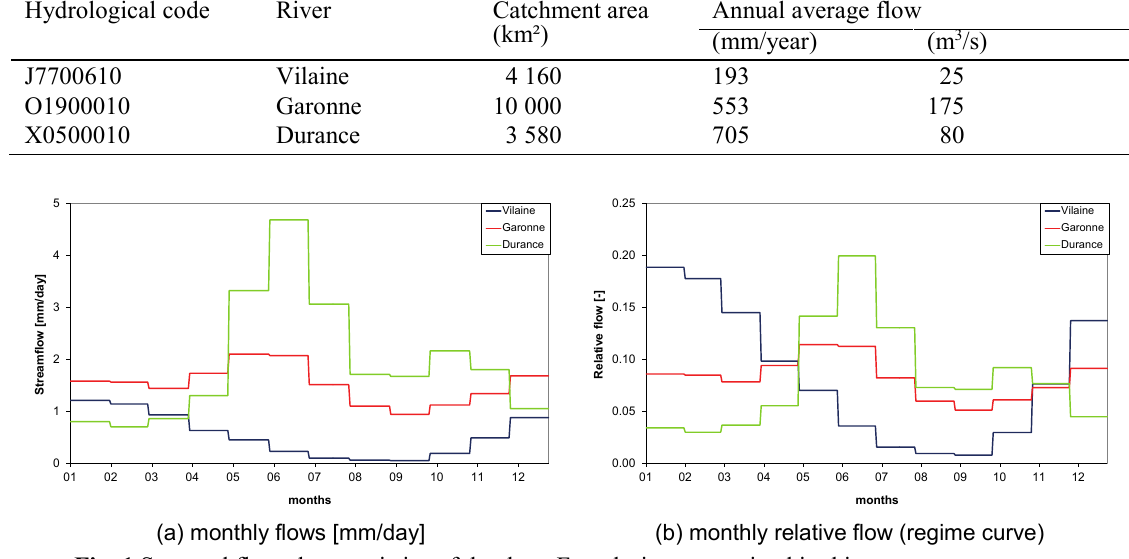
Table 1 Characteristics of the three French rivers chosen to illustrate the flow-to-resource conversion issue (average for 1960–2012). Hydrological code